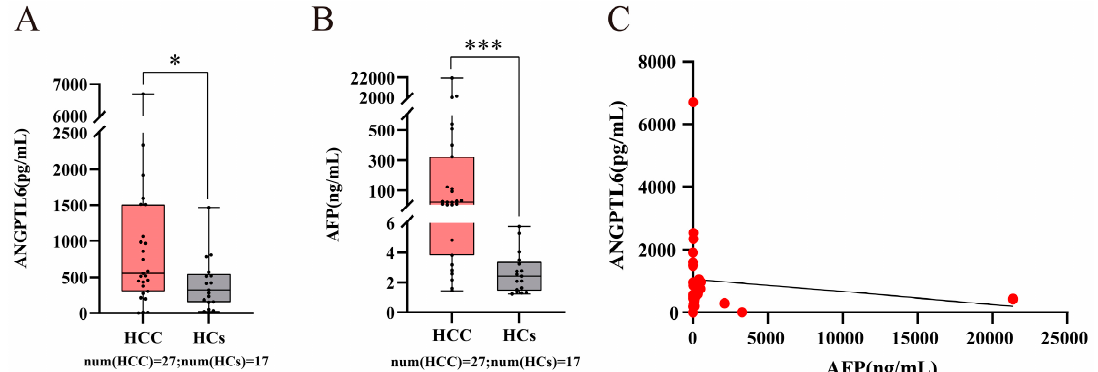
Figure 11. The expression levels of serum ANGPTL6 and AFP between early-stage HCC patients and HCs. ( A ) High levels of serum ANGPTL6 in early-stage HCC patients ( n = 27) compared with those in HCs ( n = 17) ( p = 0.035). ( B ) High levels of serum AFP in early-stage HCC patients ( n = 27) compared with those in HCs ( n = 17) ( p < 0.001). ( C ) The correlation of serum ANGPTL6 and serum AFP was analyzed using Spearman’s rank correlation analysis. * p < 0.05. *** p ≤ 0.001. Abbreviations: num, number.